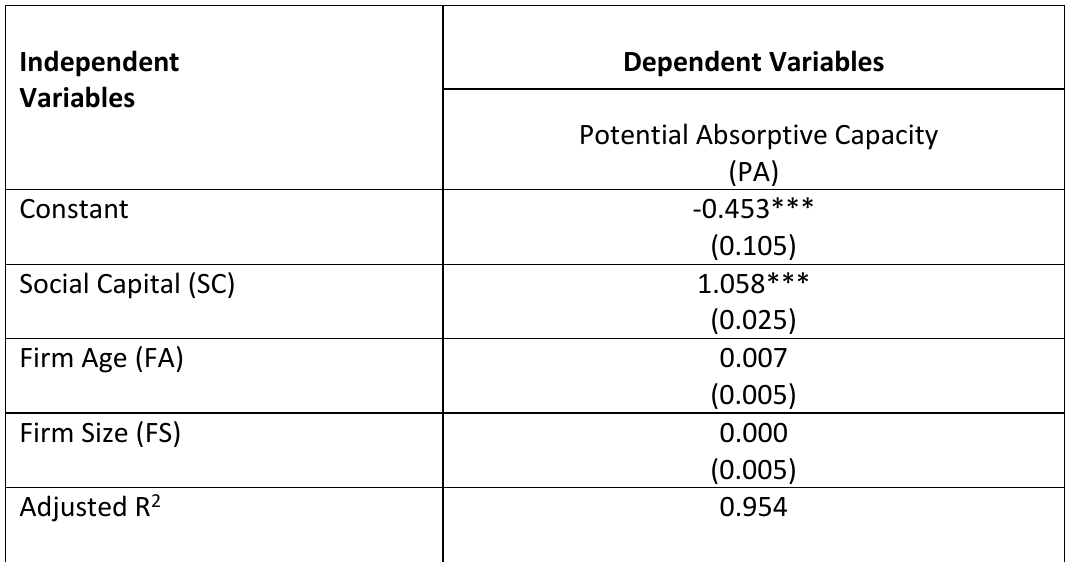
Table 3: Results of Regression